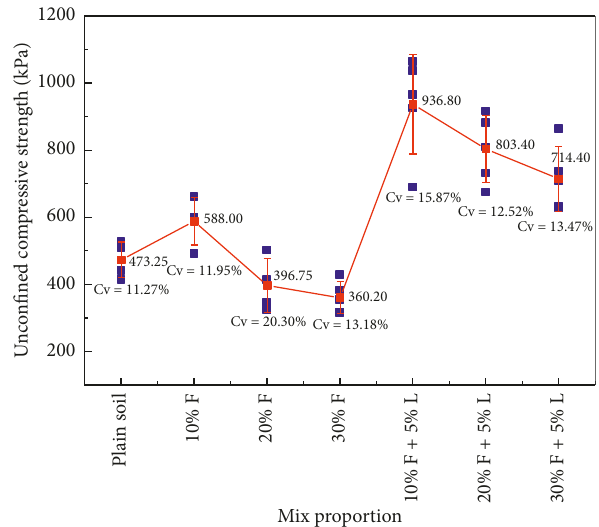
Figure 9: Unconfined compressive strength curve of stabilized soil (28 days).